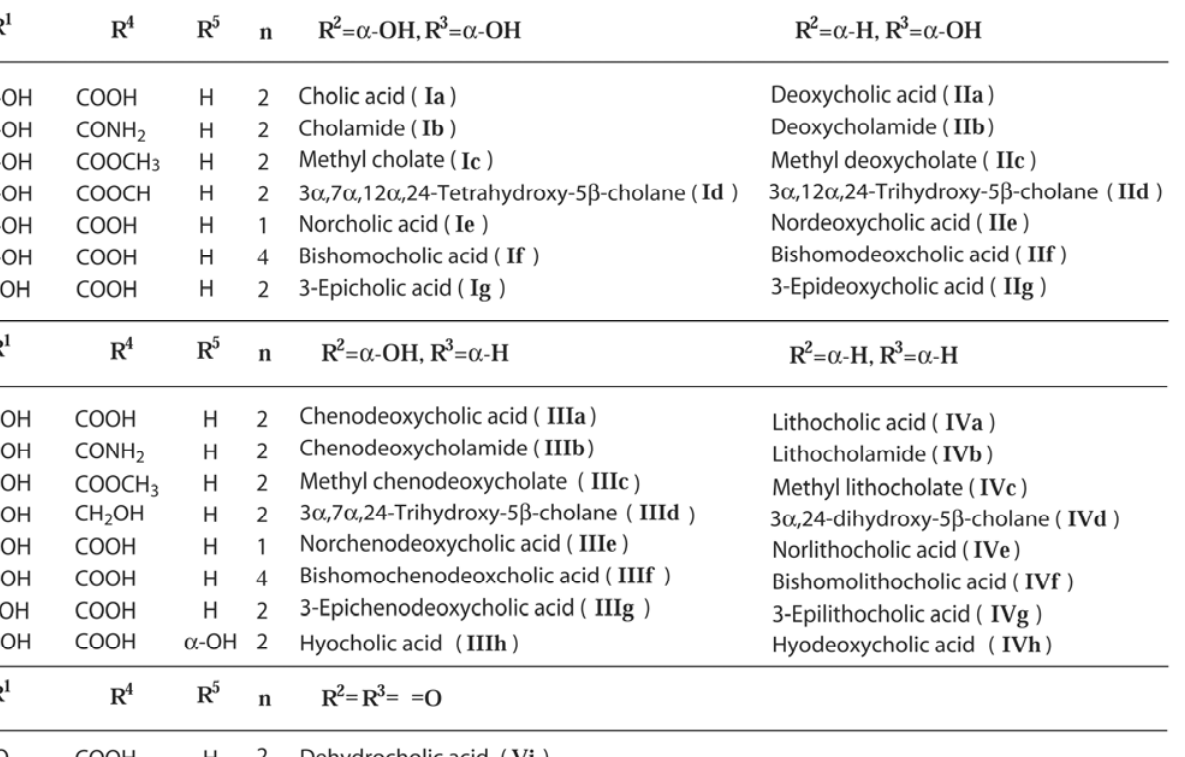
Table 1. Steroidal bile acids and their